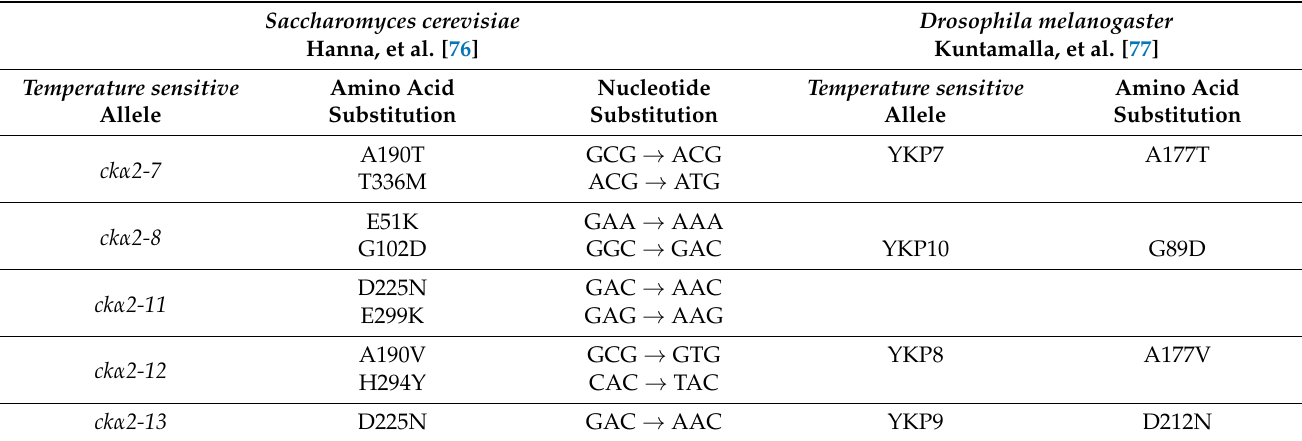
Table 2. Saccharomyces cerevisiae ck2 α temperature sensitive alleles and Drosophila melanogaster dCK2 α transgenes with temperature sensitive phenotypes in